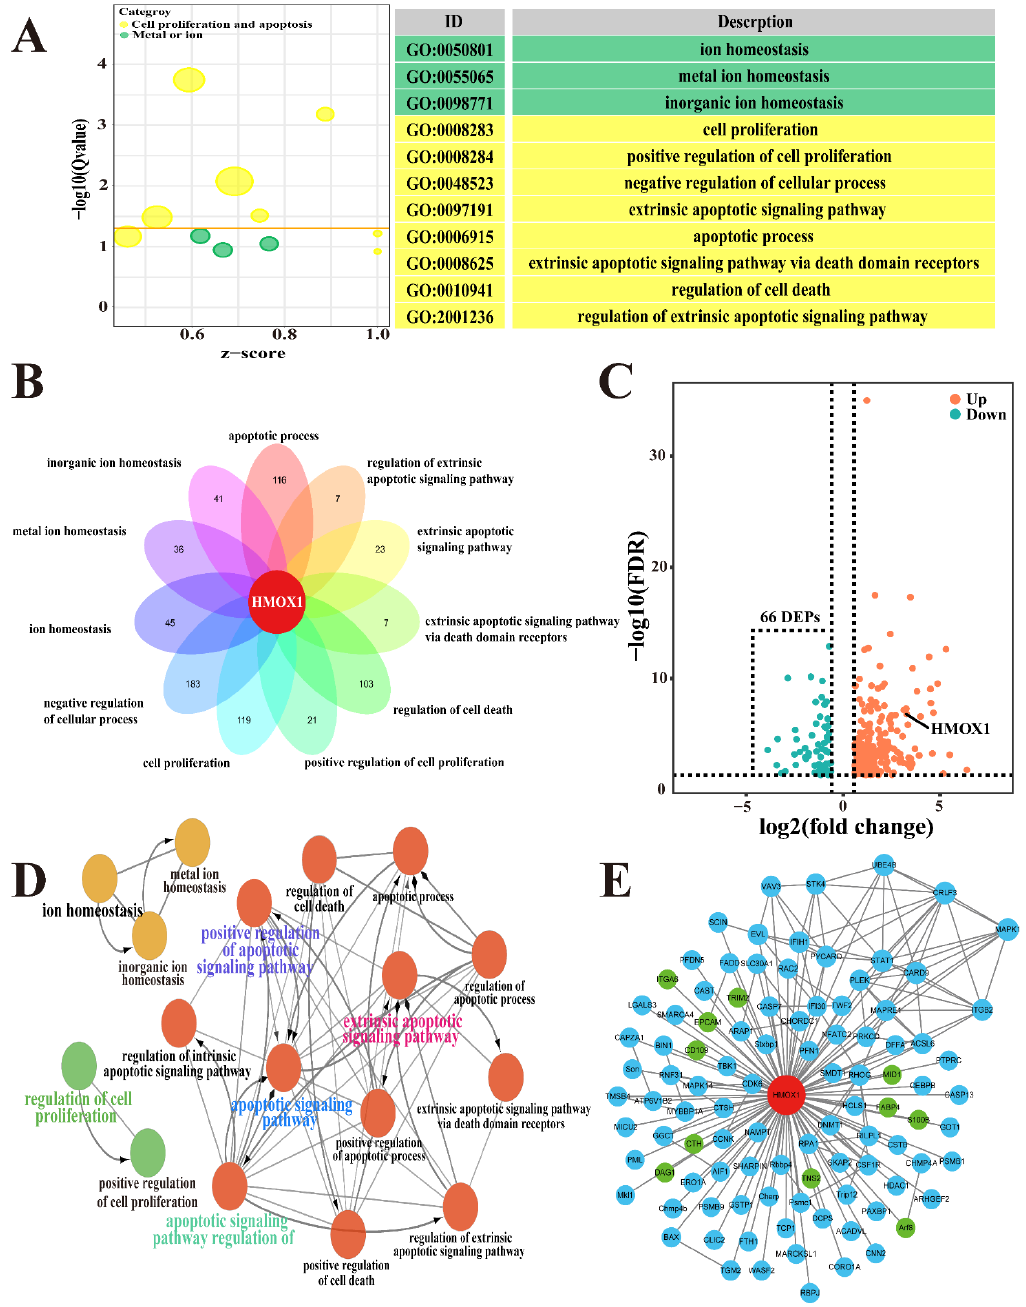
Figure 2. Identification of candidate DEPs associated with ion homeostasis, cell proliferation and apoptosis. ( A ) The significantly differential GO terms related to ion homeostasis, cell proliferation and apoptosis were selected from the DIA proteomics data. Green color represents the GO terms related to ion homeostasis. Yellow color represents the GO terms related to cell proliferation and apoptosis. ( B ) Venn diagram of the 11 GO terms selected from the DIA proteomics. ( C ) Volcano plot of the 302 DEPs included in the 11 GO terms. Blue color represents the down-regulated DEPs. Orange color represents the up-regulated DEPs. ( D ) The interaction network of the 11 GO terms related to ion homeostasis, cell proliferation and apoptosis. Green color represents the GO terms related to cell proliferation. Red color represents the GO terms related to cell apoptosis. Yellow color represents the GO terms related to ion homeostasis. ( E ) The PPI network of the 302 DEPs included in the 11 GO terms. Green color represents the 89 up-regulated DEPs. Blue color represents the 11 down-regulated DEPs. DEPs, differentially expressed